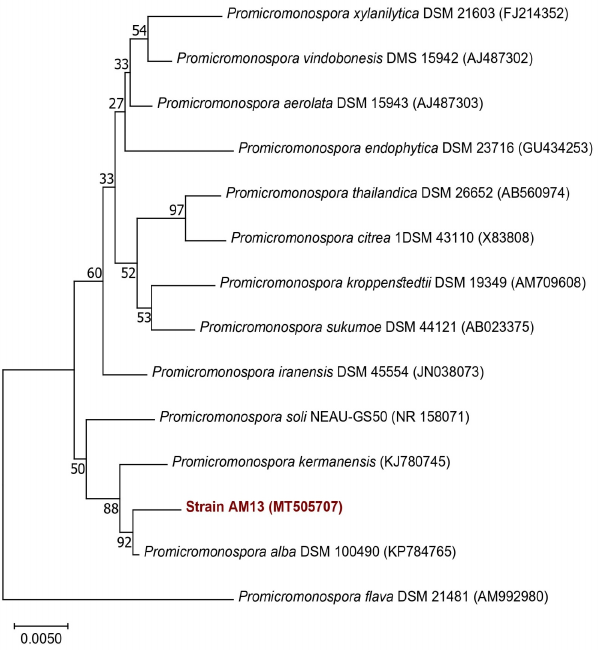
Figure 5. Neighbor-joining phylogenetic tree of the isolated actinomycete strain AM13 and 13 Promicromonospora species based on nearly complete 16S rRNA gene sequences (1400 nt). Numbers at nodes indicate levels of bootstrap support (%) based on a neighbor-joining analysis of 1000 resampled datasets; only values >50% are given.